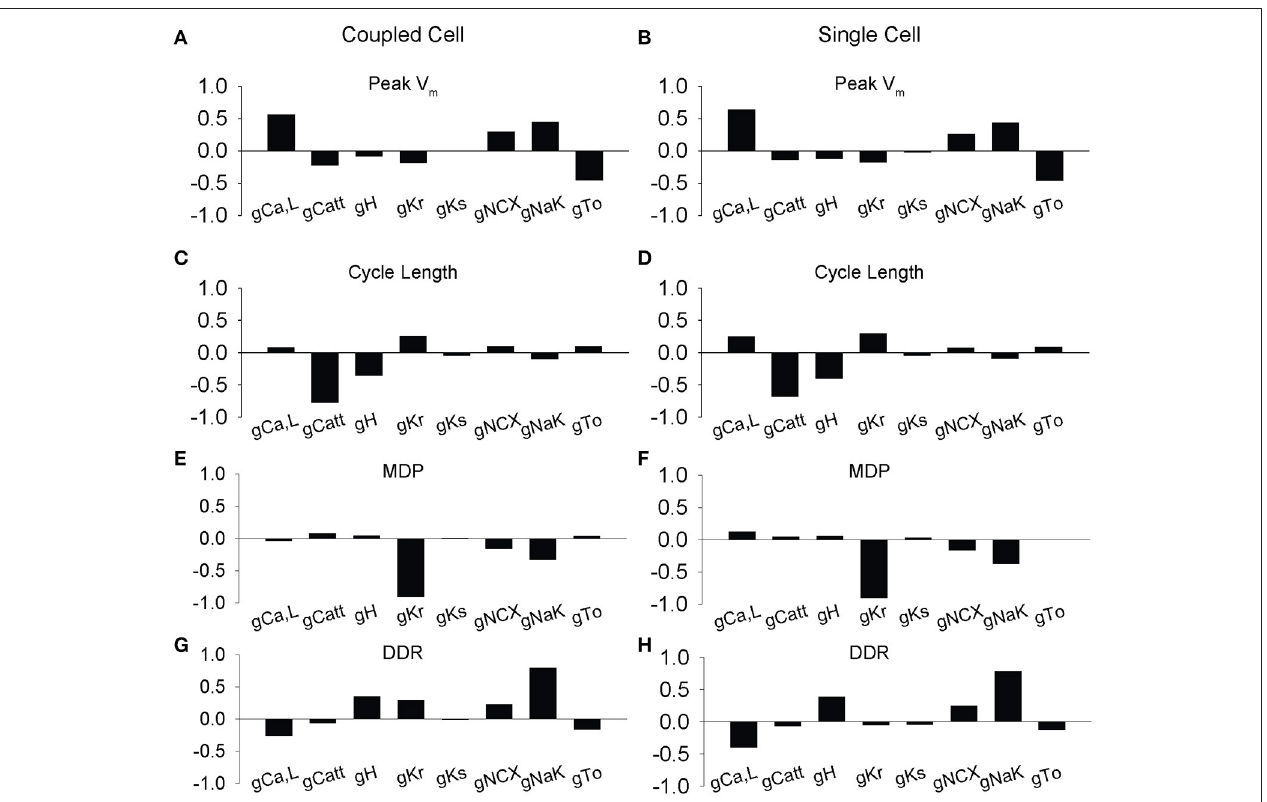
FIGURE 4 | Partial least-squares regression analysis of ionic gating variables in the rabbit sinus node model. Regression coefficients showing how changes in model parameters affect membrane dynamics in two coupled simulated SAN cells. 616 simulations were performed at a normal coupling strength (0.33) between one WT and one variant cell with random ion channel factors (L-type Ca 2 + current I Ca,L , T-Type Ca 2 + current I Ca,T , hyperpolarization-activated current I H , rapidly activating delayed rectifying K + current I Kr , slowly activating delayed rectifying K + current I Ks , Na + /Ca 2 + exchanger I NCX , Na + /K + ATP-ase I NaK , transient outward K + current I to ) perturbed over a lognormal distribution, with a mean of 1.0 and a standard deviation of 0.2. Parameter sensitivities of ion channel conductance parameters affect (A–B) peak membrane voltage, (C–D) cycle length, (E–F) max diastolic potential (MDP), and (G–H) diastolic depolarization rate (DDR). The impact of I Ca,L , I Catt , I to , I Kr , and I NaK contributed highly to membrane voltage dynamics including peak (I Ca,L , I NaK, I to ), cycle length (I Catt ), diastolic membrane voltage (I Kr , I NaK ), and diastolic depolarization rate (I NaK